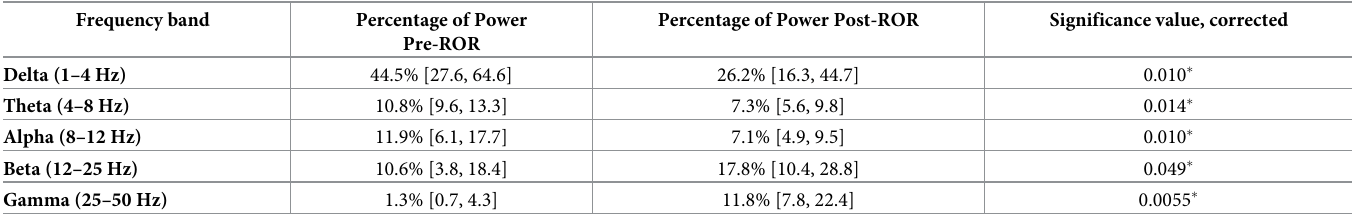
Table 2. Summary of spectral changes from before and after recovery of response (ROR).